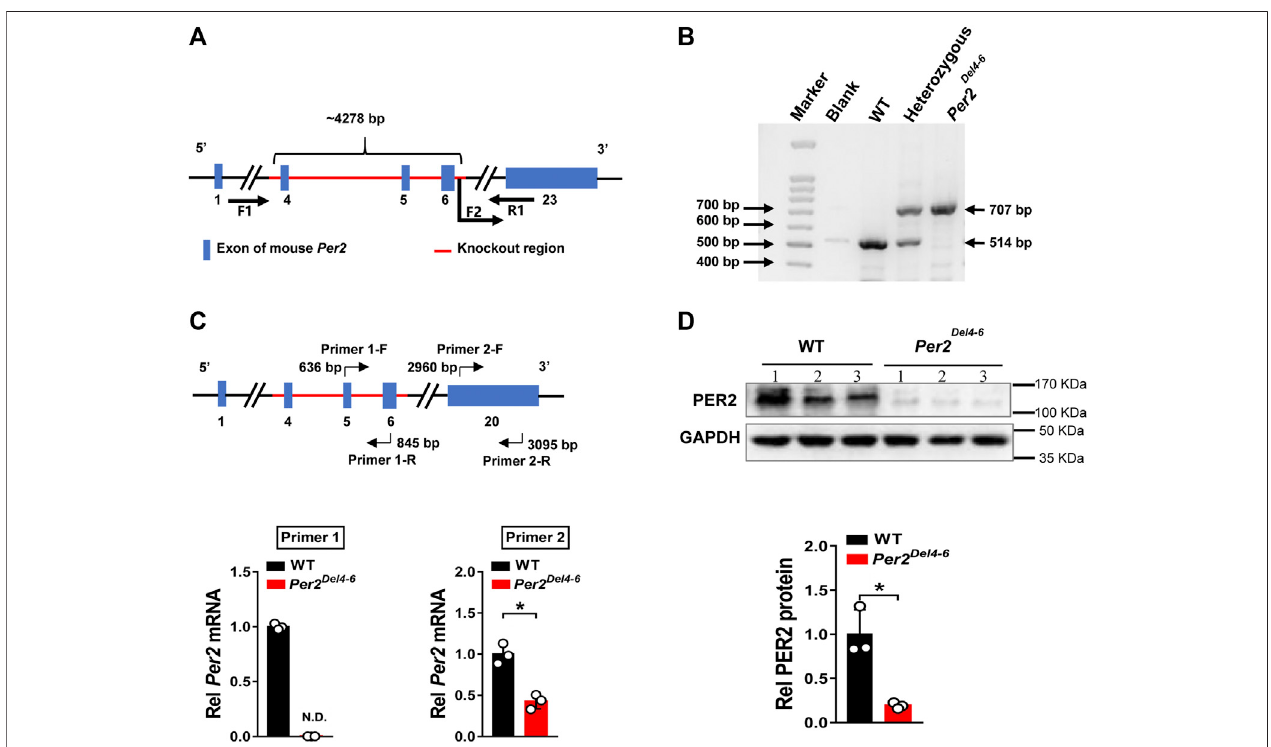
FIGURE 1 | Characterization of Per2-de fi cient mice. (A) Schematic diagram showing target site (exons 4-6) deleted for establishment of Per2 Del4-6 mice. (B) PCR genotypingusingmousetailsfromwild-type(WT),heterozygousandhomozygous( Per2 Del4-6 )mice. (C) qPCRanalysesof Per2 in Per2 Del4-6 andWTmice.Thetoppanel showsthetargetsitesofprimersets1and2. (D) WesternblottinganalysesofPER2proteinin Per2 Del4-6 andWTmice.Westernblotstrips(atargetproteinandaloading control) were cut from one gel. Data are mean ± SD ( n (cid:1) 3). *p < 0.05 (t test).